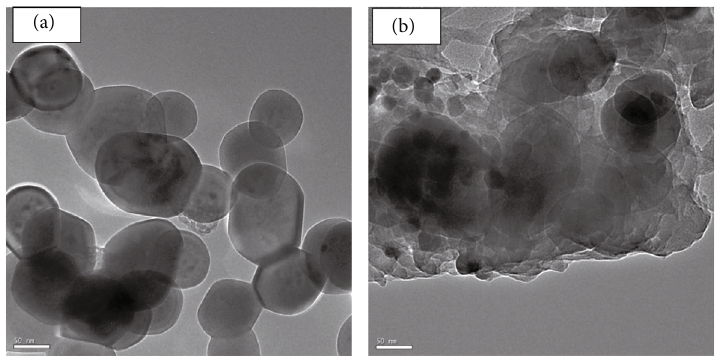
Figure 1: (a) TEM of CuFe